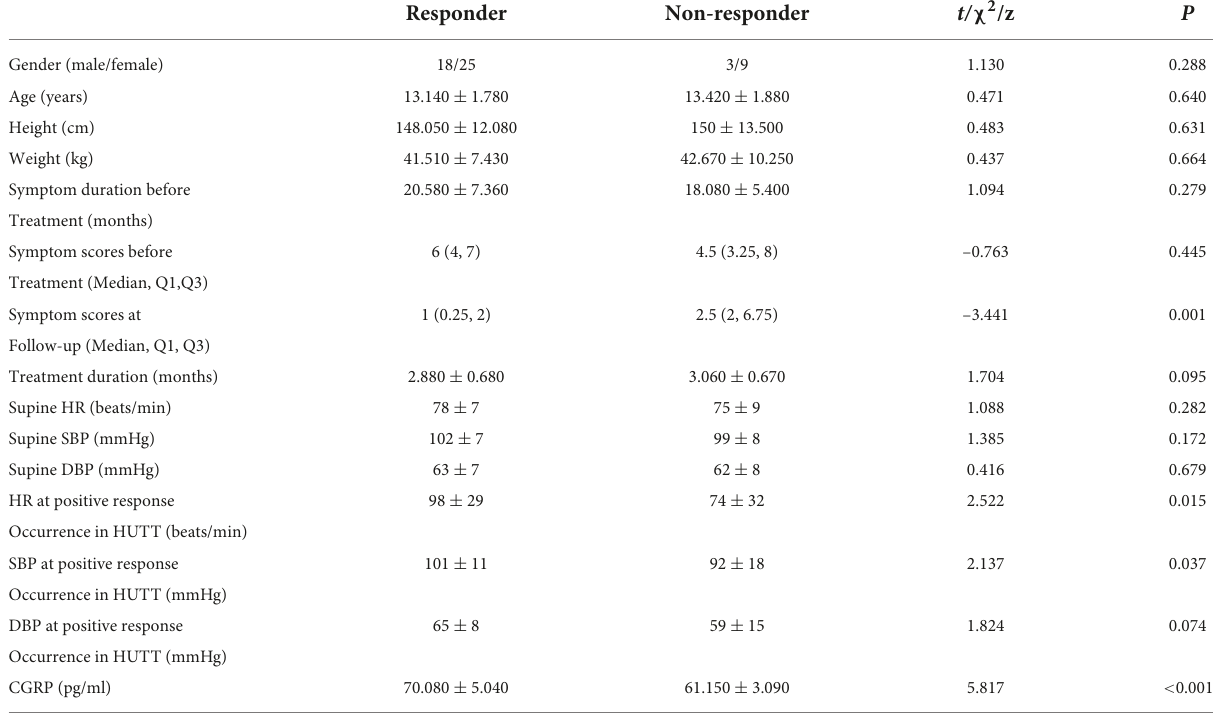
TABLE 4 Analysis of demographic data and clinical features in VVS subjects treated with midodrine